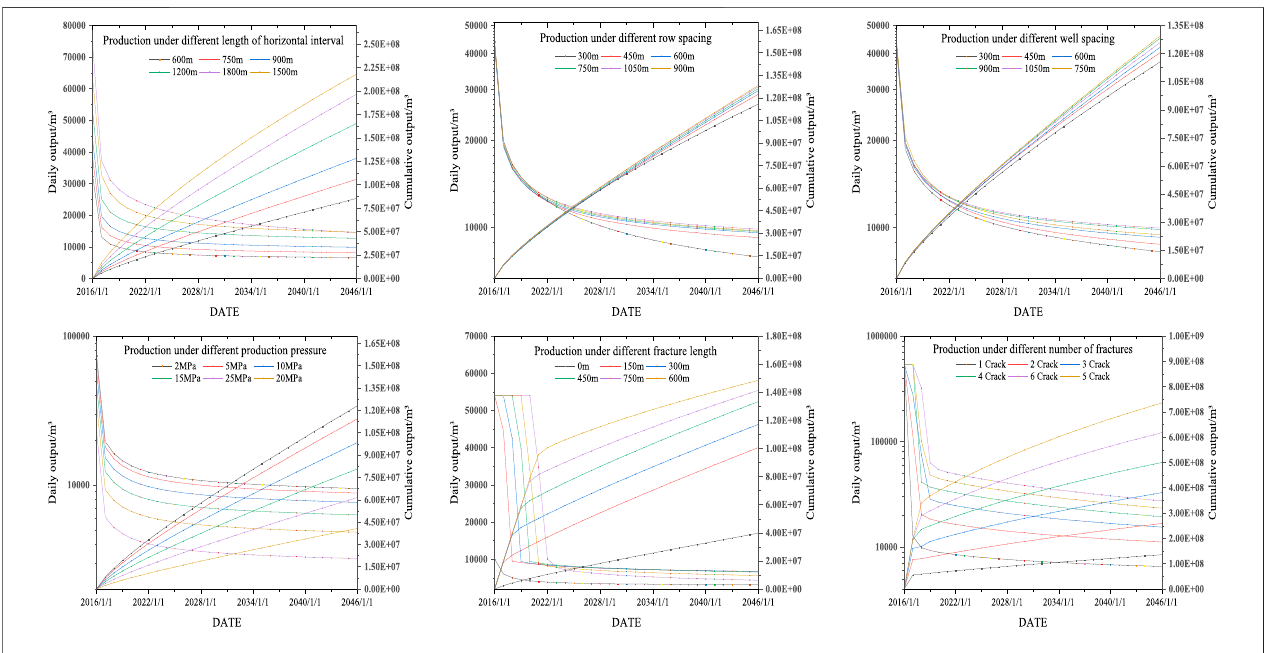
FIGURE 11 | Production of a well under diffusion